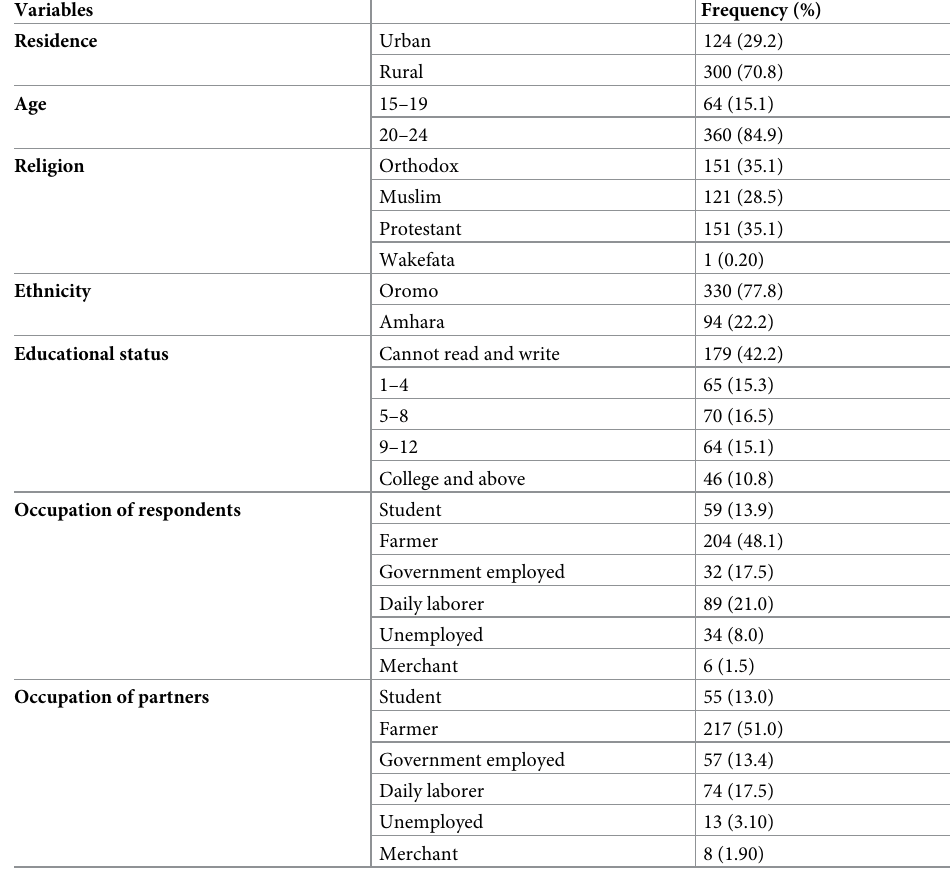
Table 1. Socio-demographic characteristics of currently pregnant married women youths of Kiremu district, Oro- mia, Ethiopia, 2020.